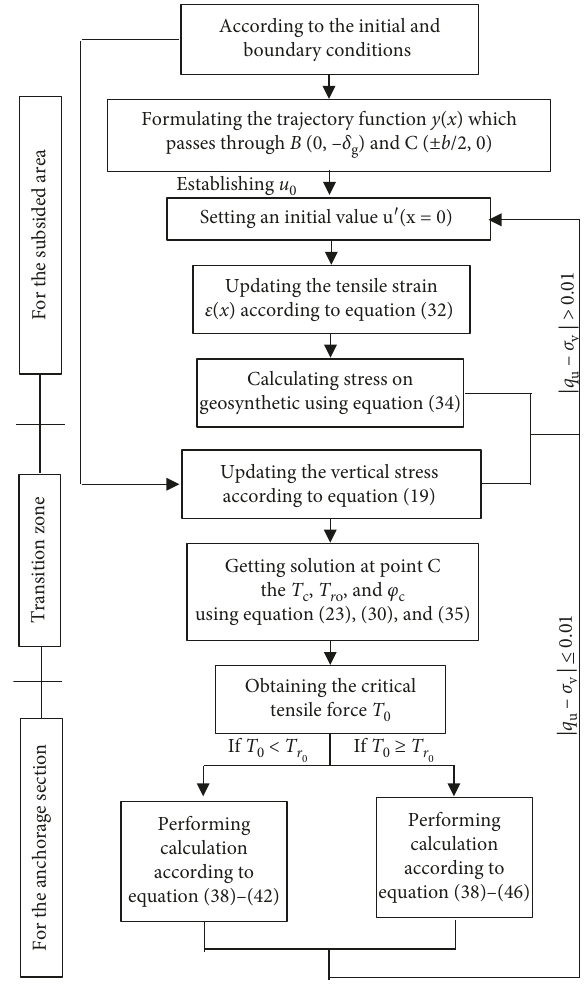
Figure 9: Iterative calculation procedure of the proposed